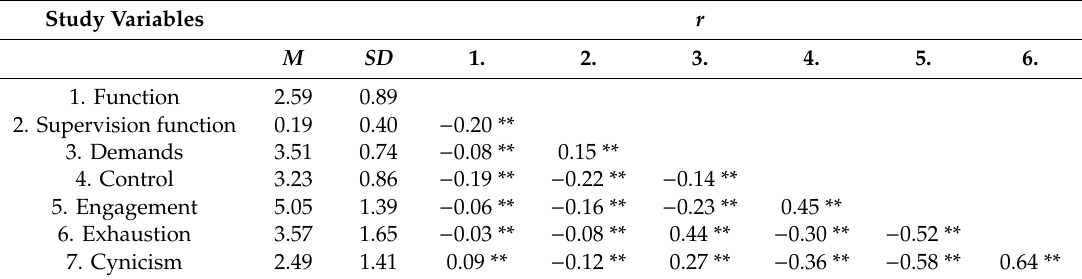
Table 1. Means (M), standard deviations (SD), and correlations (r) of the study variables. Study Variables r